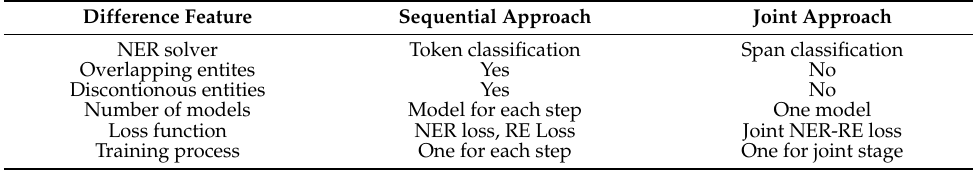
Table 5. The differences between sequential and joint